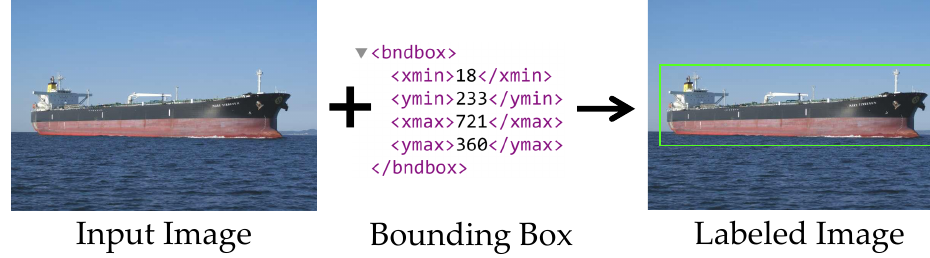
Figure 9. Example of a bounding